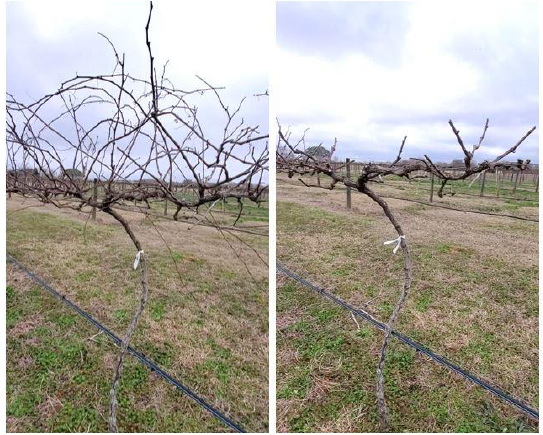
Figure 1. ‘MidSouth’ grapevine before ( left ) and after ( right ) spur pruning to 60 buds in McNeill, MS (February 2021).